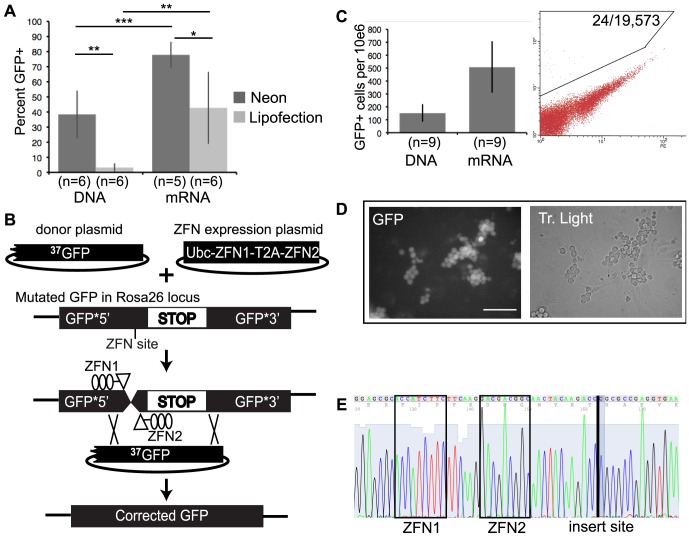
ZFN-mediated genome editing in GS cells.(A) Neon transfection (1200/30/1) was used to transfect 3×10e5 cells with 1.0 µg of em-GFP plasmid DNA (pCDNA6.2/emGFP) or 1.0 µg of capped and poly-adenylated mRNA coding for pmaxGFP and transfection efficiency was quantified by flow cytometry three days after transfection. Lipofectamine-2000 was used to transfect the same ratio of cells:DNA or cells:mRNA as in the Neon experiment. The mean and standard deviation of percentage of GFP+ cells from three experiments are shown. (*p<0.05, **p<0.01,***p<0.001, Student T test). (B) Schematic depicting the two plasmids used in genome editing experiments. The donor DNA (“37GFP”; plasmid BE356) contains a fragment of the GFP coding sequence lacking the first 37 nucleotides and serves as a donor template. “Ubc-ZFN1-T2A-ZFN2” (plasmid M500) contains a bicistronic expression cassette with a human Ubiquitin C promoter driving expression of two ZFNs directed to a recognition site in the GFP gene and separated by a T2A skip sequence. GS cell lines were derived from mice carrying a mutated GFP gene, with a 85 nucleotide stop codon and frame shift insertion (labeled “STOP”), introduced into the ROSA26 locus by standard knockin technology [25]. (C) 0.8 µg of Ubc-ZFN1-T2A-ZFN2 (M500) plasmid or 0.8 µg each of synthesized mRNA ZFN1 and ZFN2, together with 2.4 µg donor plasmid (BE356), were transfected (1400/20/1) into MPG6 cells on day 1 and genome editing events were quantified on day 5 or 7 (data pooled). Histogram shows mean +/- standard error mean. The dot plot shows sample results of a single transfection of donor DNA and ZFN mRNAs. (D) GFP fluorescence (left) or corresponding transmitted light image in GT59 cells following two sorts to enrich for GFP+ cells. Bar represents 50 microns. (E) Chromatogram showing corrected GFP gene sequence of PCR amplified genomic DNA from GT59 cells. The ZFN recognition sites are indicated by boxes and the site in which the mutation was replaced by donor DNA is indicated by a line.